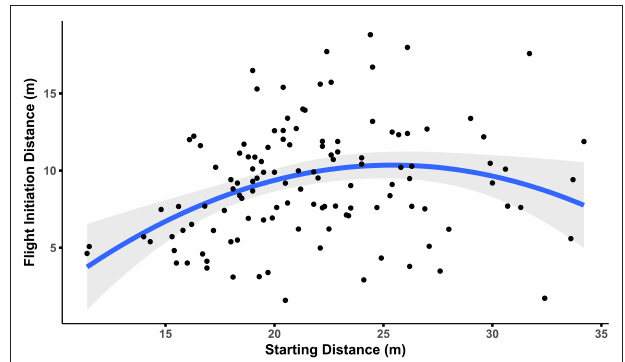
FIGURE 4 | As squirrel distance to Tree 2 increases, the probability of choosing Tree 1 (the nearest tree) as a refuge increases. There is a significant interaction between squirrel distance to Tree 1 (SDT1) and squirrel distance to Tree 2. Lines depict the relationship between squirrel distance to Tree 2 and the probability of choosing Tree 1, with line color indicating the level of squirrel distance to Tree 1. When squirrel distance to Tree 1 is small, squirrel distance to Tree 2 has a stronger effect on the likelihood that the squirrel will choose Tree 1.